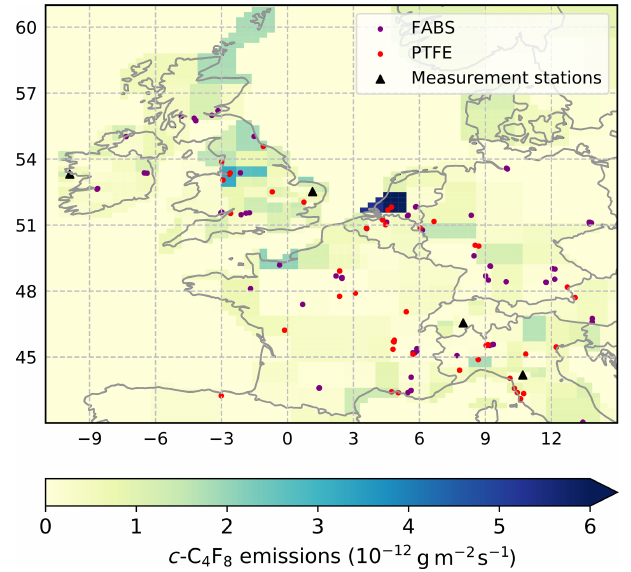
Figure 8. Mean c -C 4 F 8 emission strength (shades of green and blue, 10 − 12 gm − 2 s − 1 ) in northwestern Europe (42 to 59 ◦ N and − 11 to 15 ◦ E) from 2013 to 2017 determined by the In- TEM inversion from measurements at four sites (Mace Head, Ireland, Tacolneston, United Kingdom, Jungfraujoch, Switzer- land, and Monte Cimone, Italy, black triangles). Also shown are potential industrial emitters of c -C 4 F 8 . Locations of poten- tial TFE/HFP/PTFE/FEP production facilities (red dots) are based on company websites (3M, Chemours, Daikin, DuPont, Saint- Gobain, and Solvay) and are much less certain than the cor- responding location information for eastern Asia. Also shown are semiconductor fabrication plants (purple dots, https://en. wikipedia.org/wiki/List_of_semiconductor_fabrication_plants, last access: 3 December 2018; http://www.10stripe.com/featured/map/ semiconductor-fabs.php, last access: 3 December 2018; and other